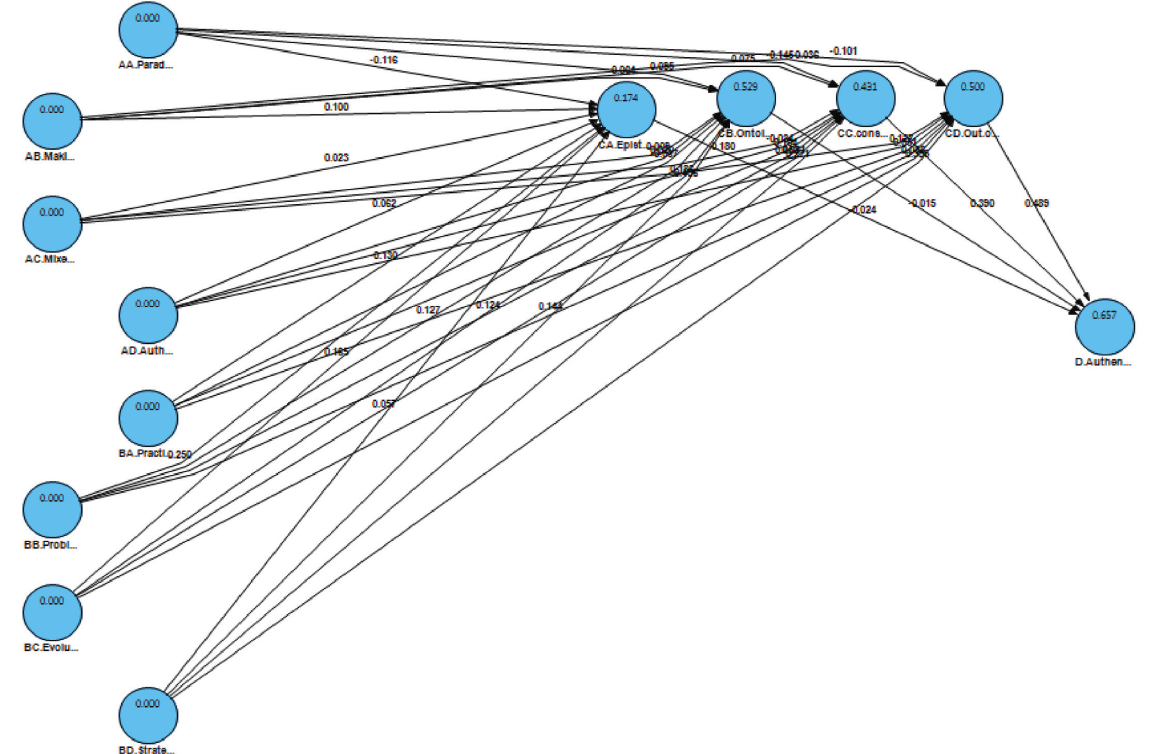
Figure 8: The internal model of second-order hypotheses in the general standard case.